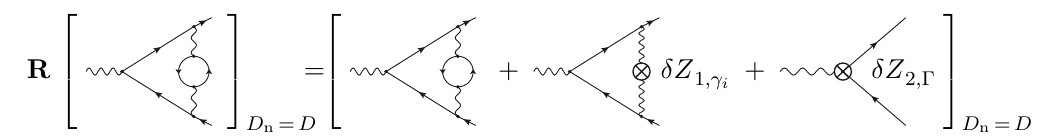
Figure 4 . Graphical representation of the renormalisation formula (5.18) for a two-loop QED diagram with a single